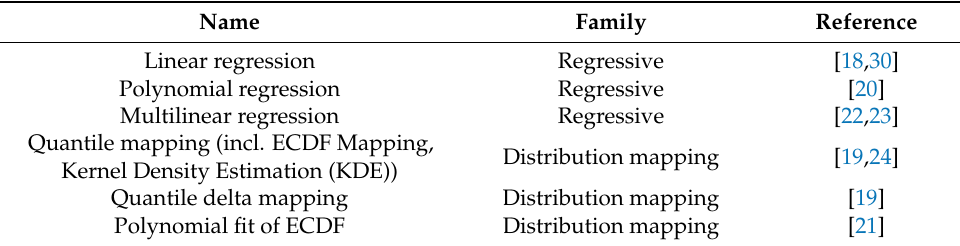
Table 1. Site-adaptation methods used in this